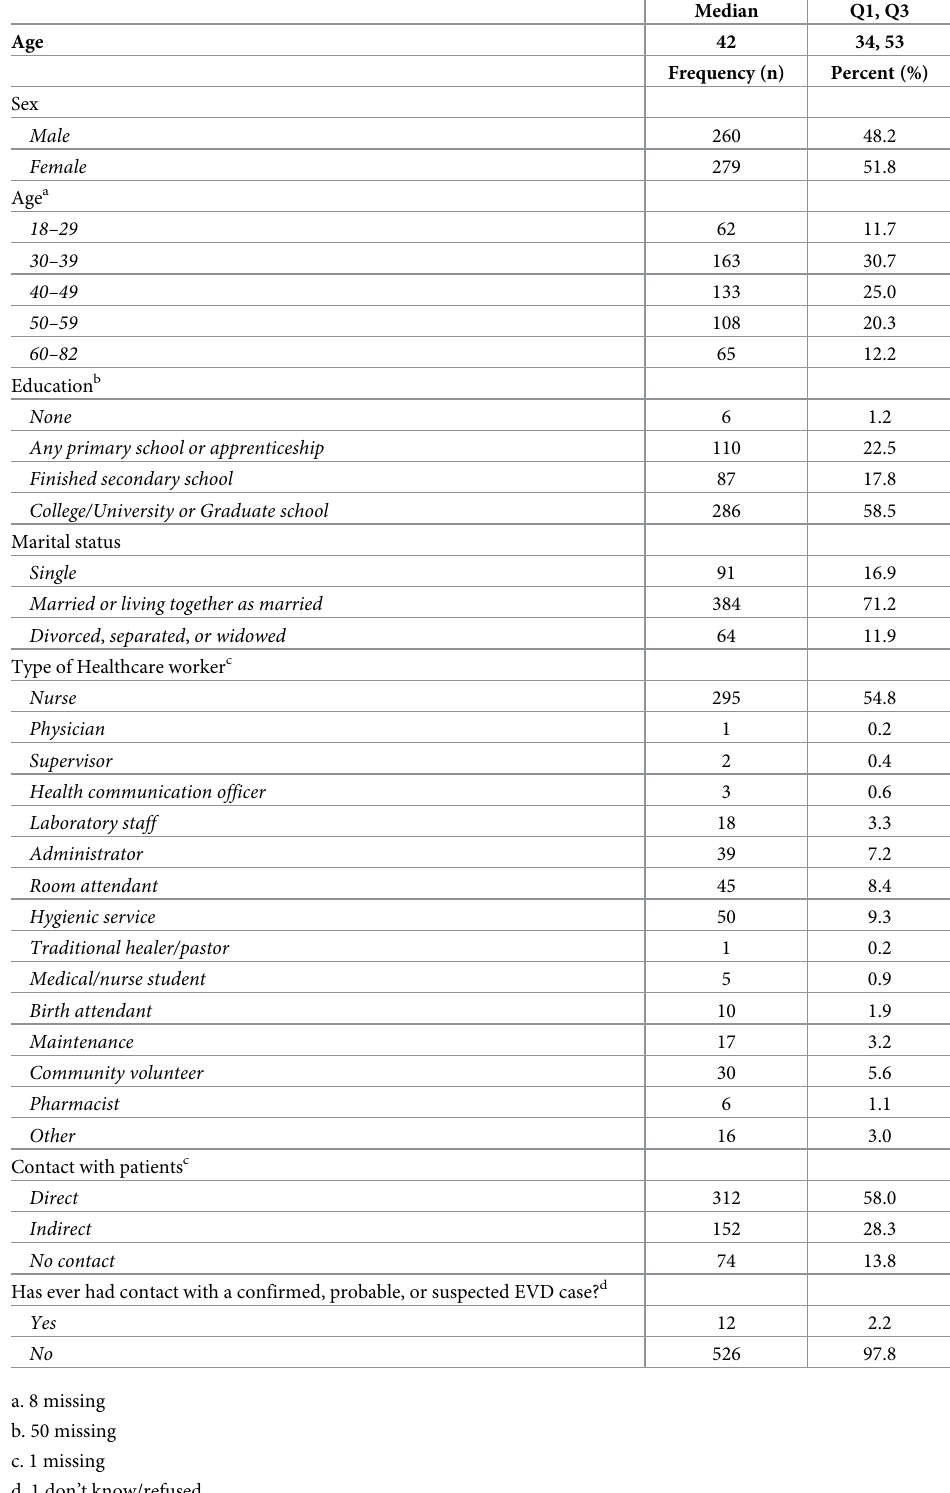
Table 1. Sample characteristics of 539 participants from Mbandaka and the surrounding areas in the Democratic Republic of the Congo, August